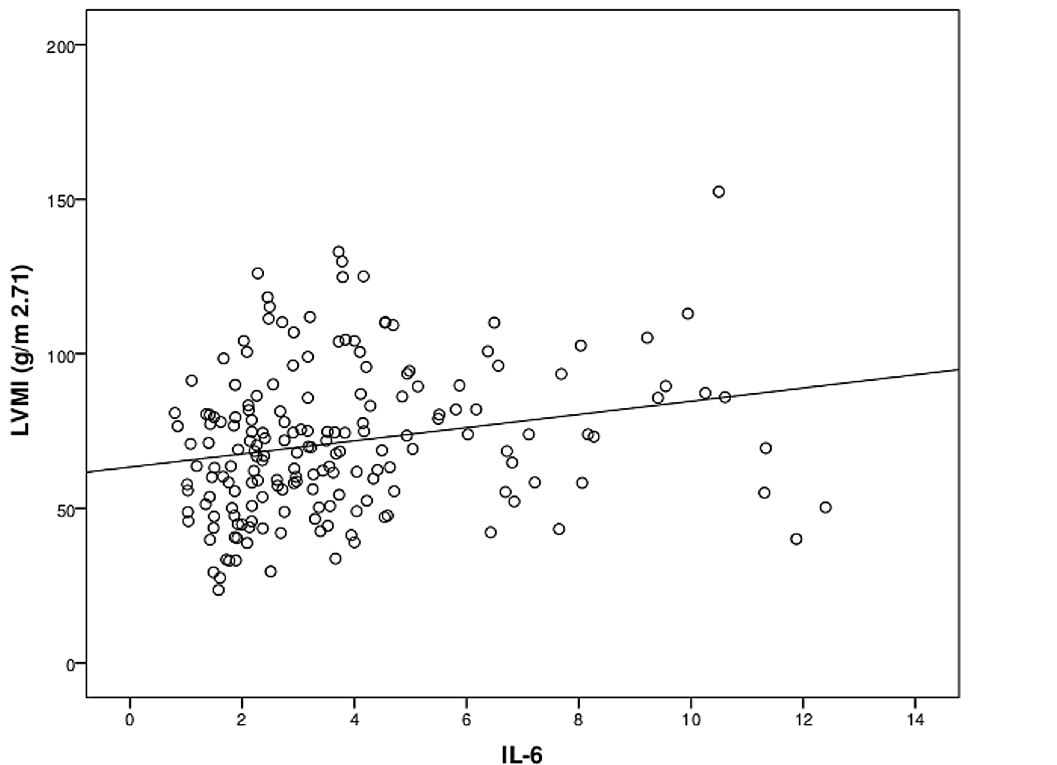
Fig 1. Correlation between IL-6 with left ventricular mass (g/m 2 (cid:1) 71 ) (n = 182).